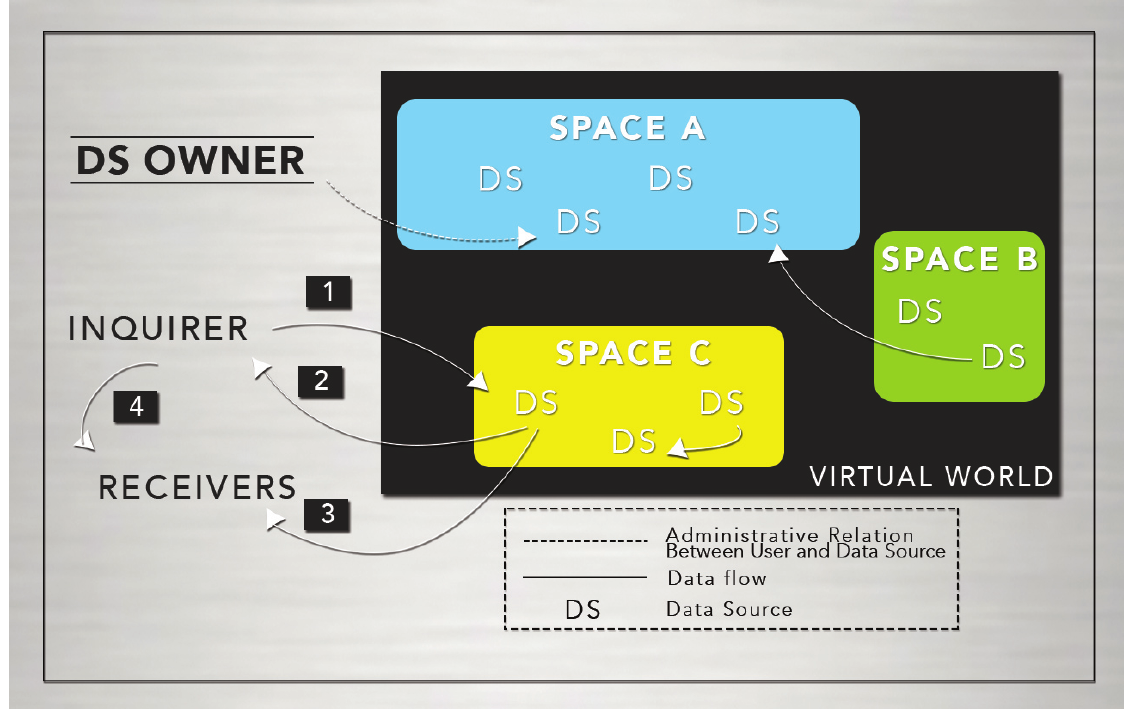
Figure 1. Graphical representation of the privacy